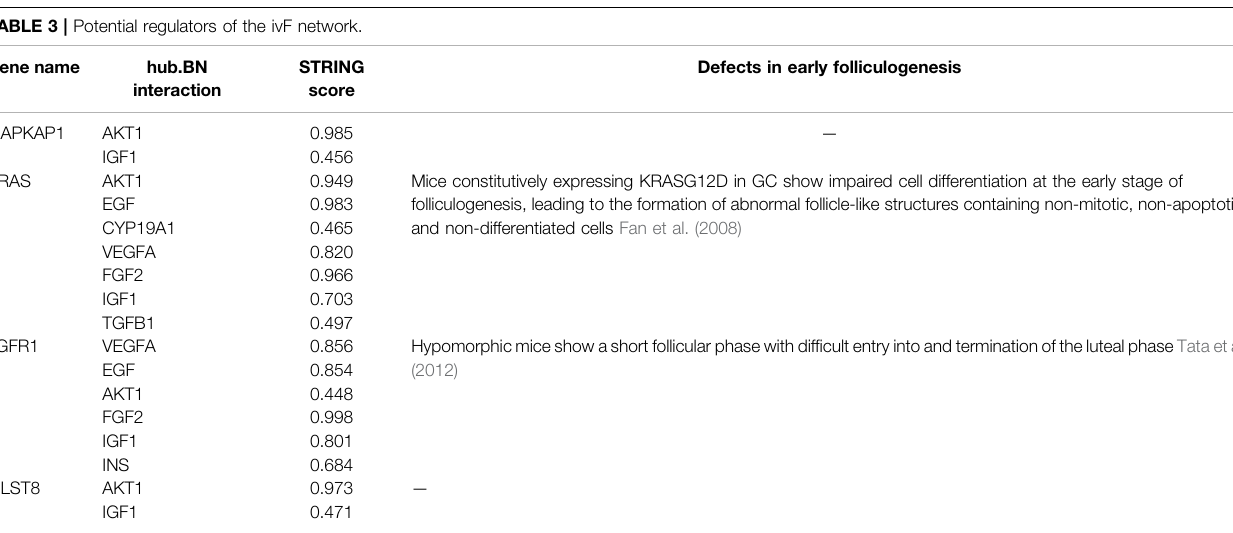
TABLE 3 | Potential regulators of the ivF